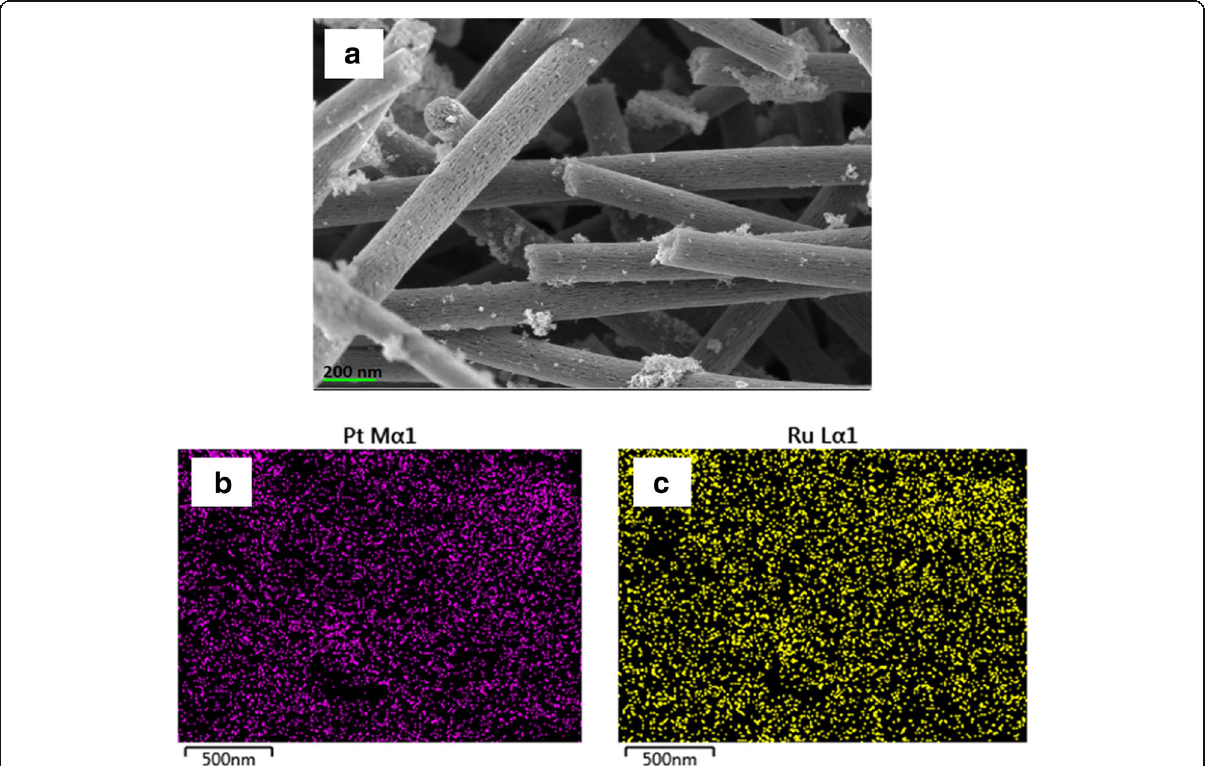
Fig. 10 PtRu/TiO 2 -CNF catalyst after deposition and milling. a SEM images (magnification × 30,000), b mapping of Pt nanoparticles, and c mapping of Ru nanoparticles